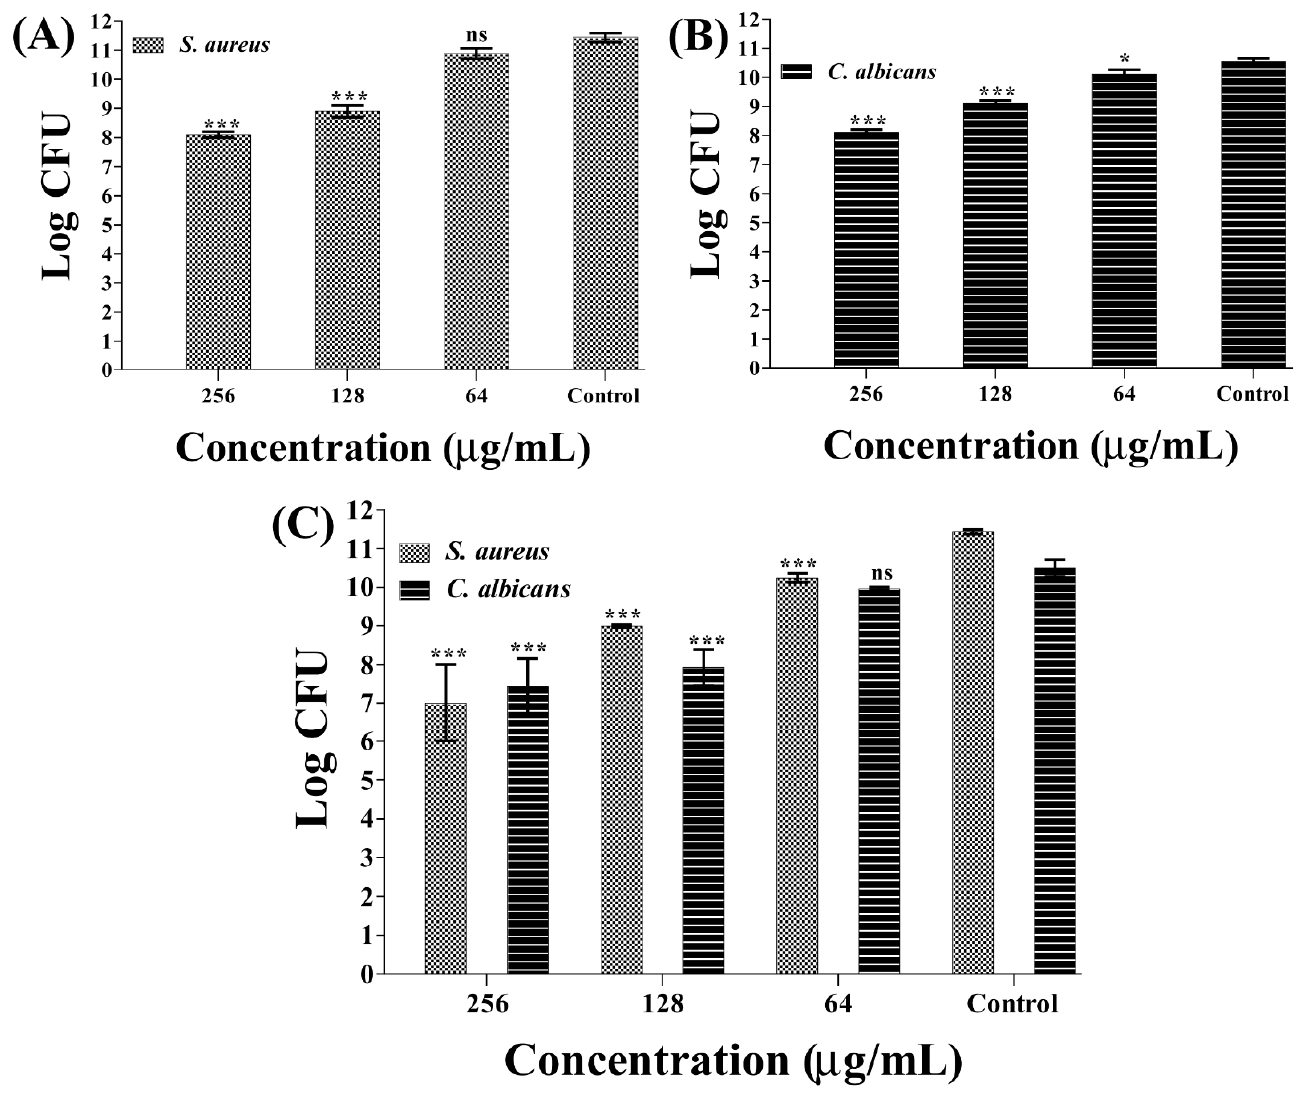
Figure 6. Inhibition of the initial stage of biofilm formation by β -c-AuNPs. ( A ) CFU of S. aureus cells, ( B ) CFU of C. albicans cells, and ( C ) CFU of C. albicans and S. aureus cells from mixed biofilms. *** p < 0.0001 and * p < 0.05 are statistically significant compared to the control, whereas ns is non-significant.